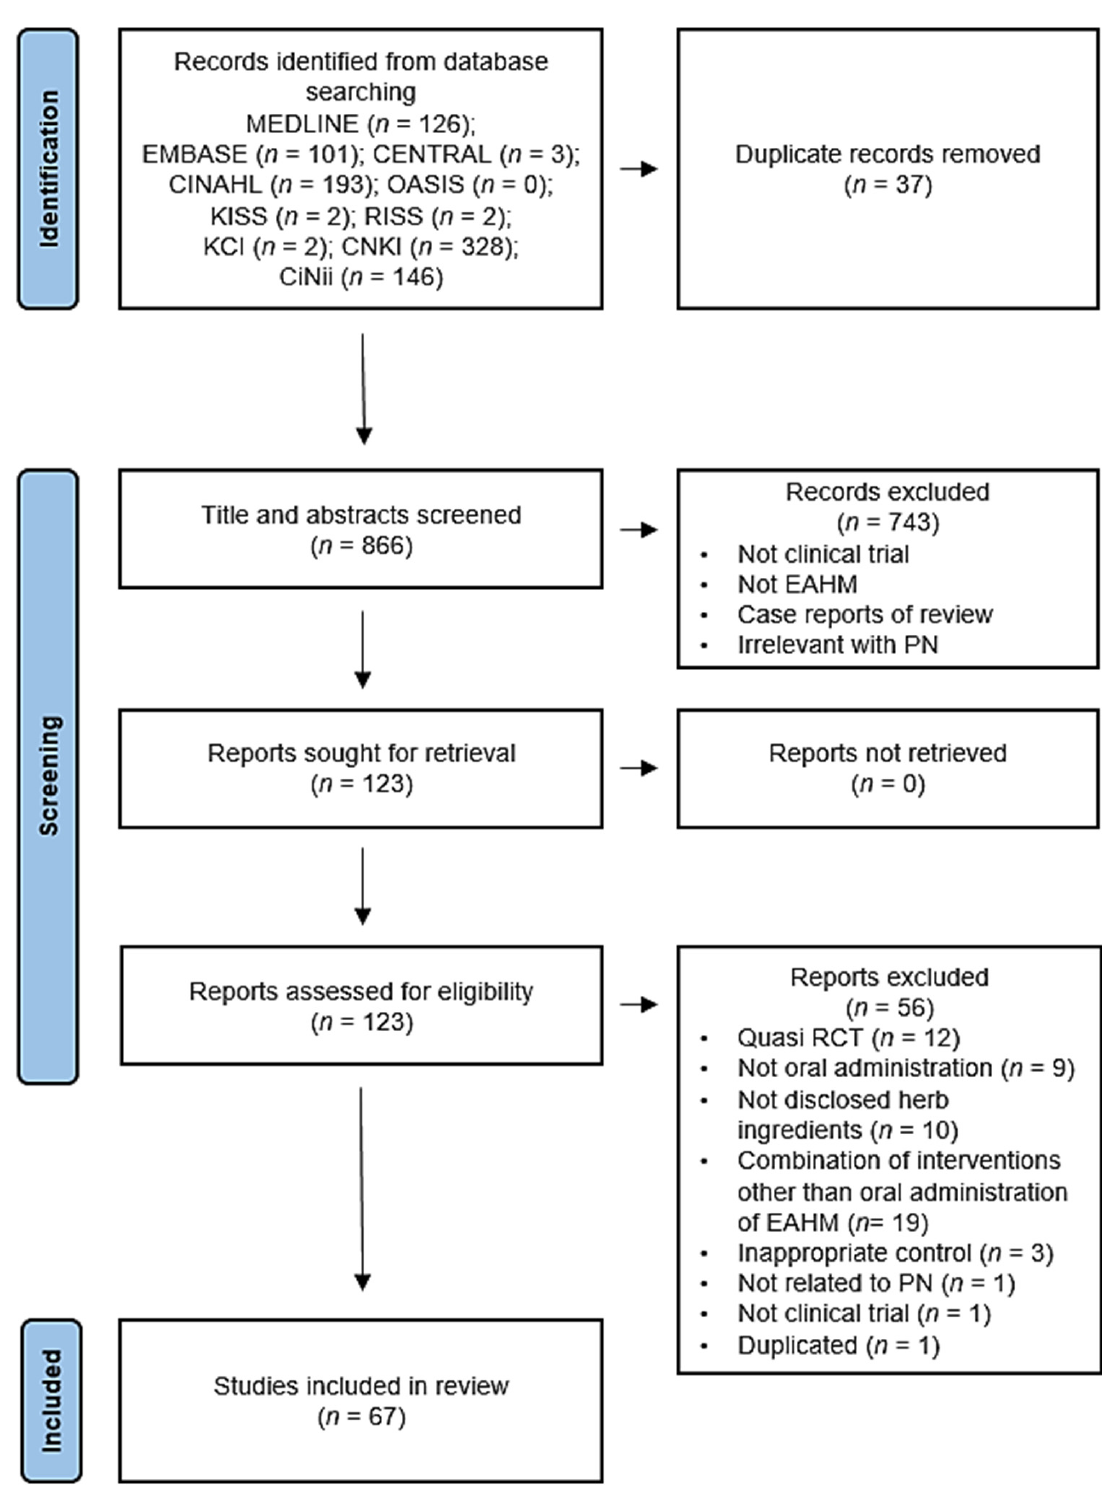
Figure 1. PRISMA 2020 flow diagram.